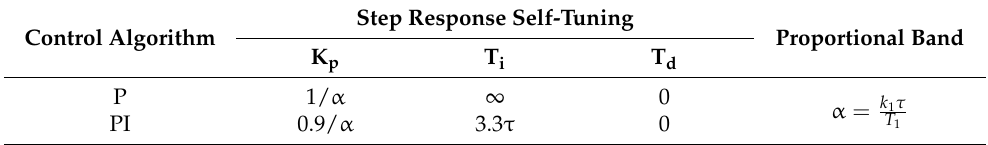
Table 3. PI parameters self-tuning